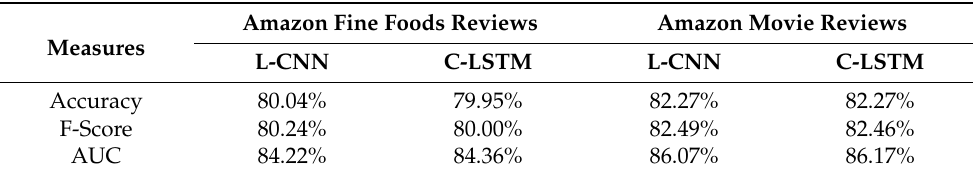
Table 2. Sentiment performance of hybrid deep-learning models.